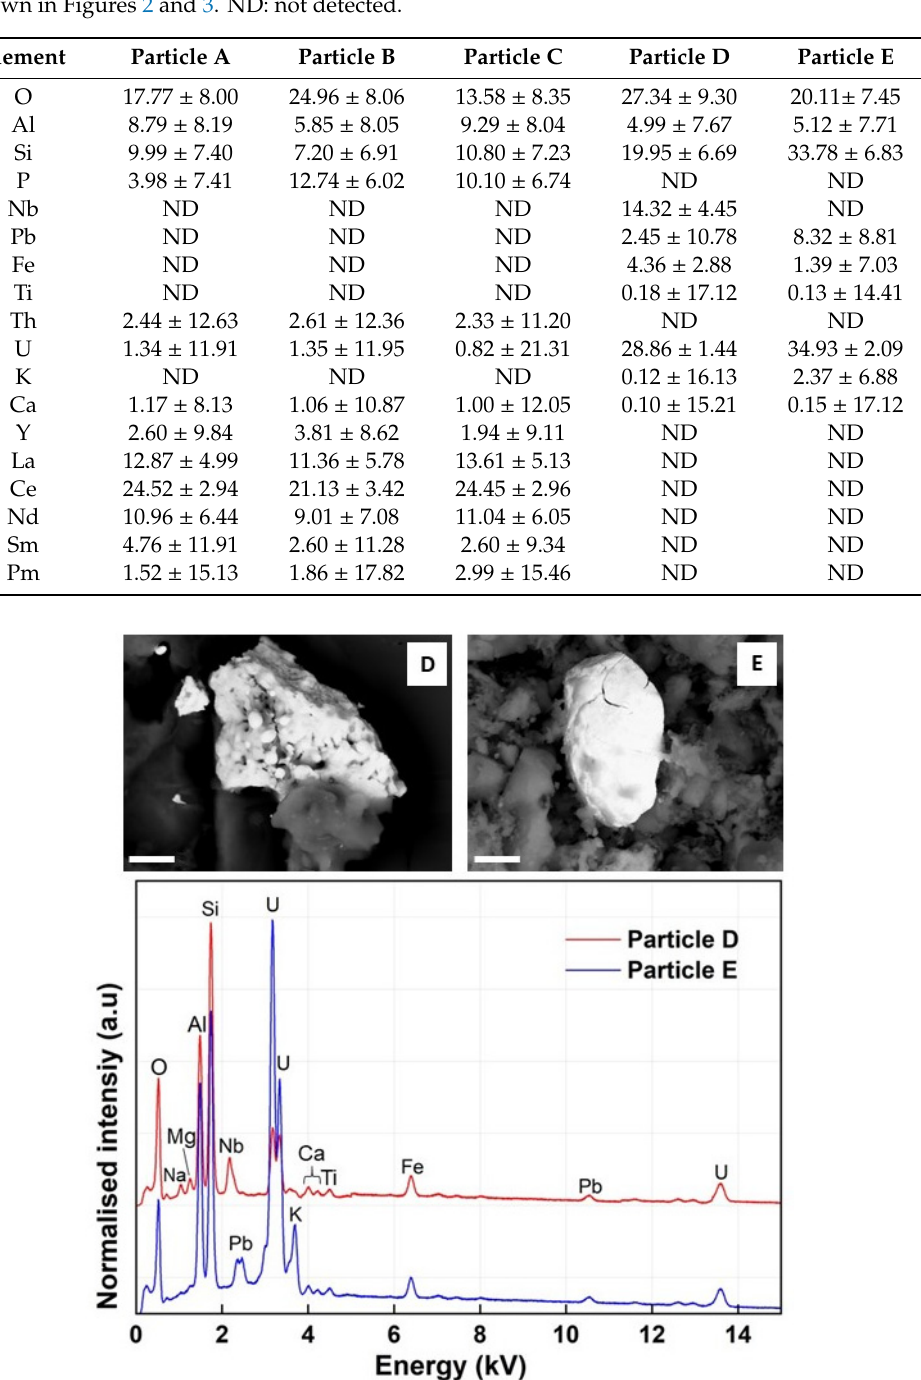
Table 9. Elemental composition (wt. % ± δ ) of particles A , B , C , D, and E determined via EDS analysis as shown in Figures 2 and 3. ND: not detected.